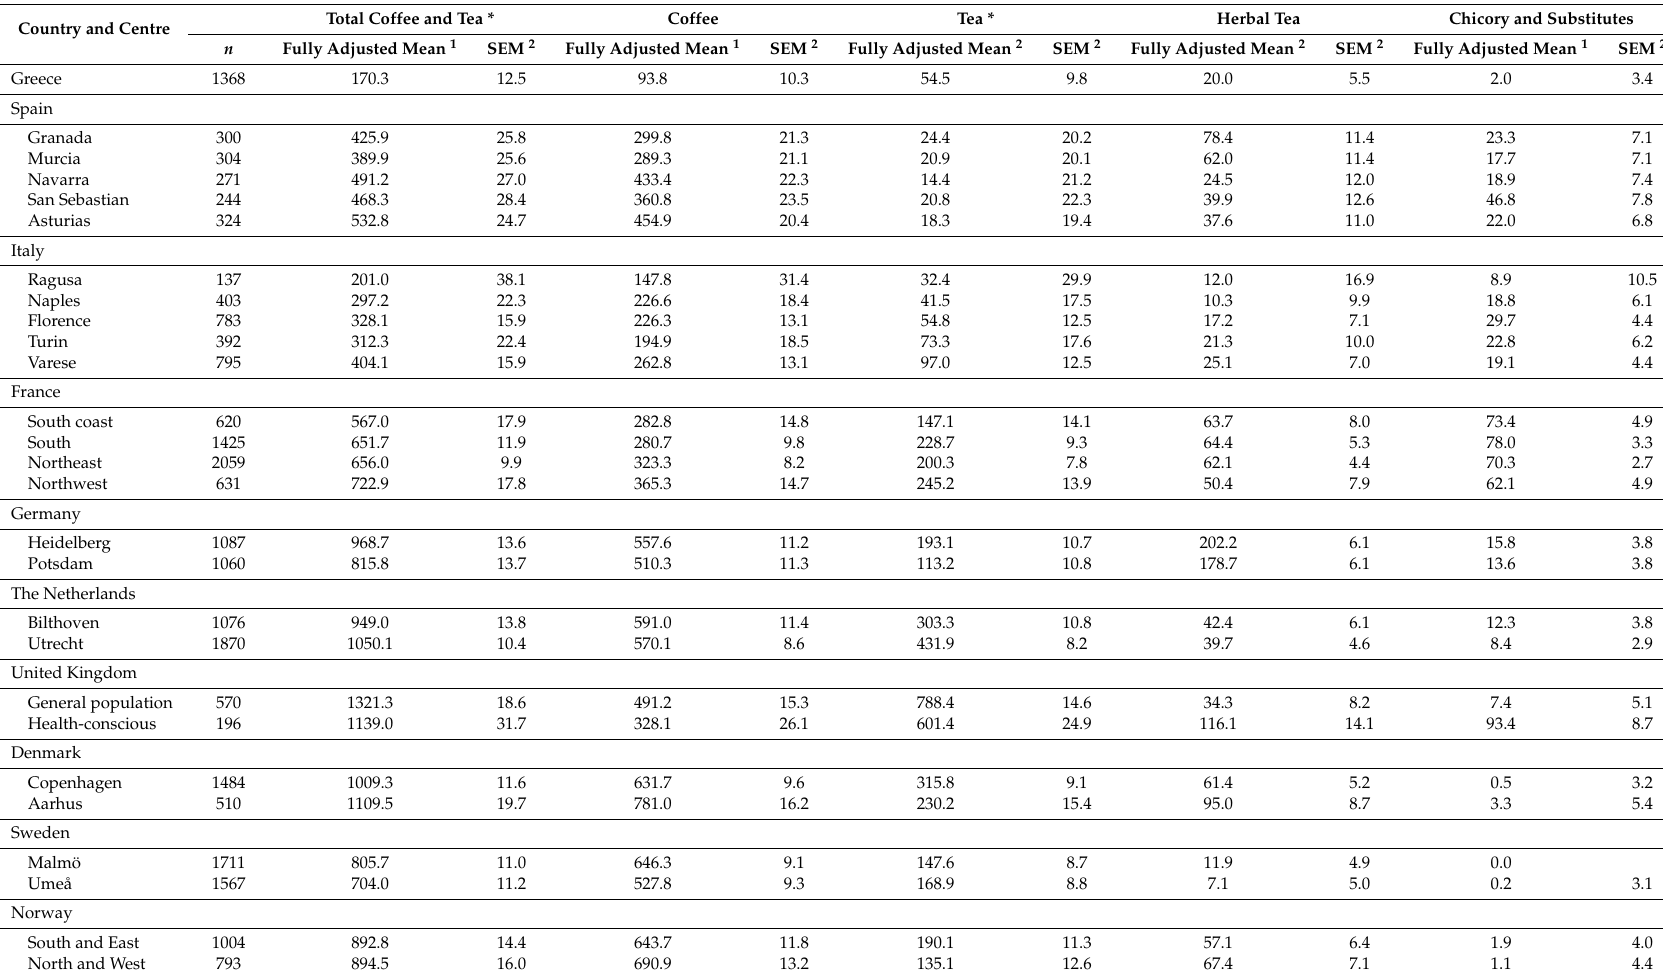
Table 2. Mean daily intake of coffee and tea (g/day) by type in the EPIC calibration study population based on 24-H Dietary Recall among women across EPIC centres ordered from South to